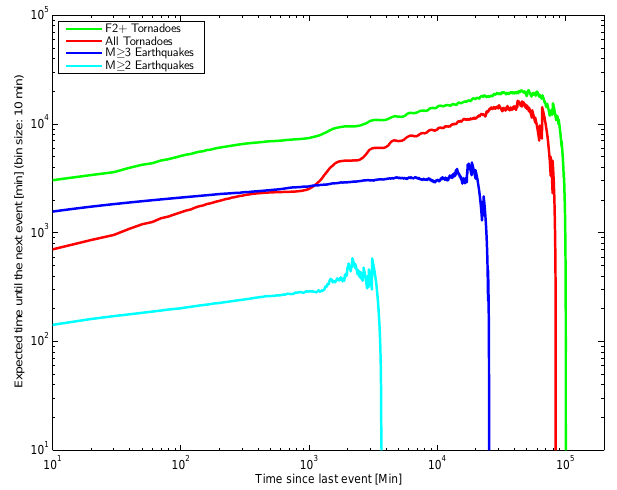
Fig. 5. Expected time until the next event: for all tornadoes (1950– 2006, USA, red curve) and for tornadoes with Fujita intensities larger than or equal to F 2 ( F 2+ tornadoes, 1950–2006, USA, green curve), for earthquakes (1981–2000, SCSN catalogue) with magni- tudes M ≥ 3 (dark blue curve), and with magnitudes M ≥ 2 (light blue curve). Data in 10min bin sizes.